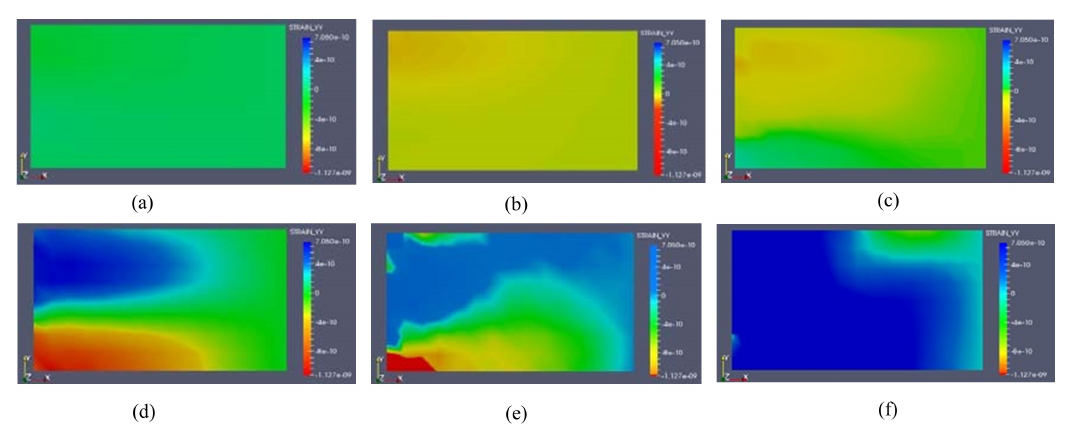
Figure 9. Vertical strain contour of SO-02 at ( a ) 0.5 MPa, ( b ) 2.5 MPa, ( c ) 10 MPa, and ( d ) 50 MPa in compression, and ( e ) 25 MPa and ( f ) 0.5 MPa in recovery.